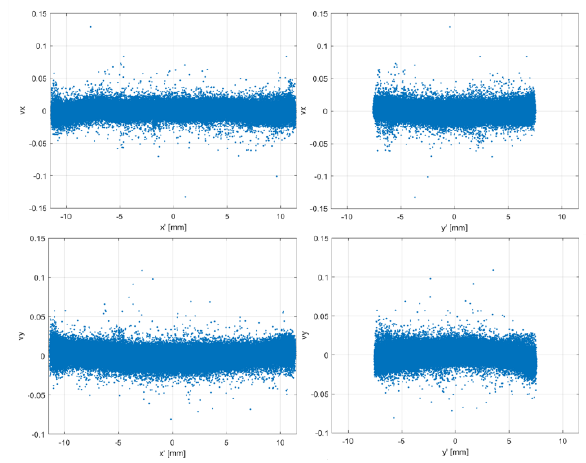
Figure 17. Residual components plotted against image coordinate components for Canon B+L